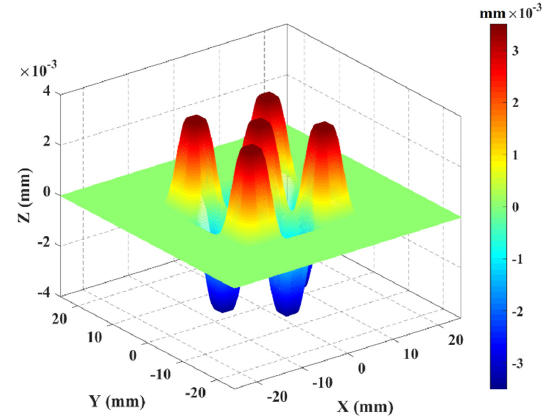
Figure 3. Description of the traceability chain in asphere and freeform metrology.